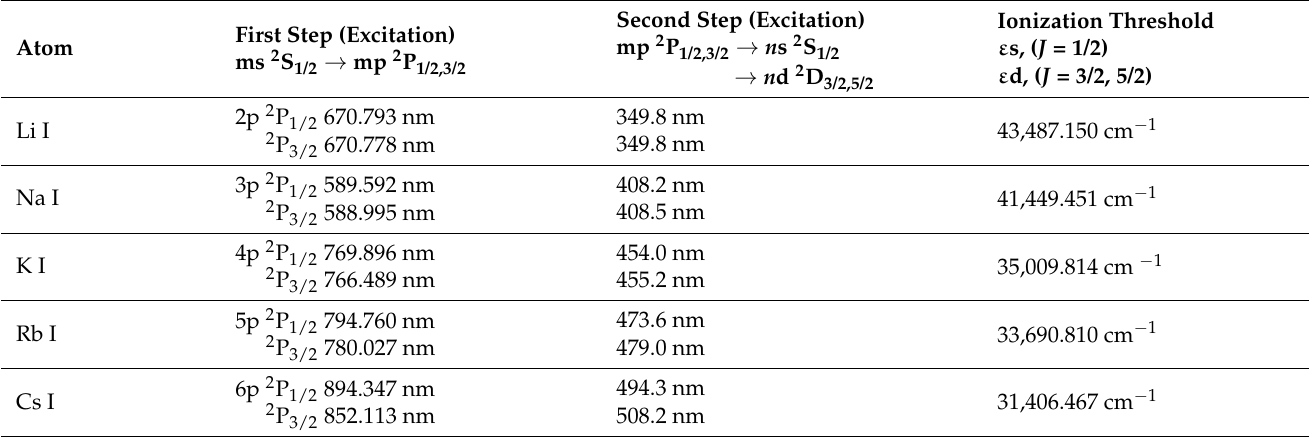
Table 1. Two-step excitation and ionization laser wavelengths for the alkali